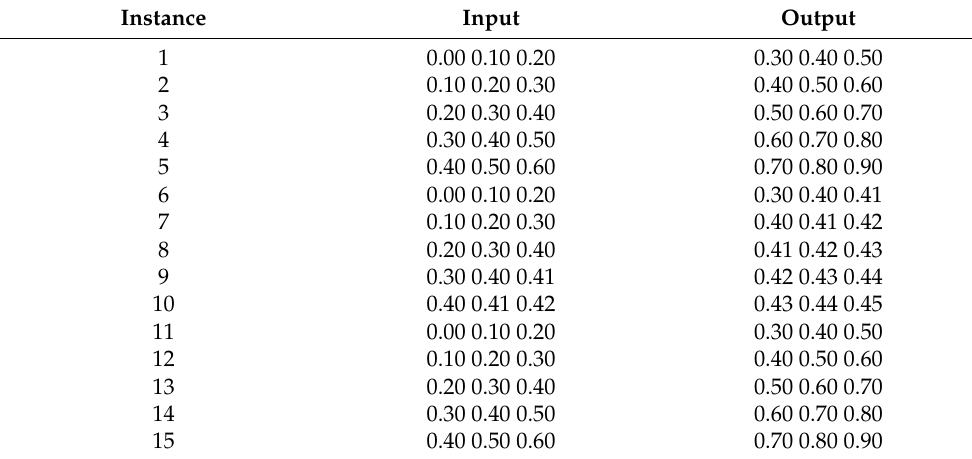
Table 2. The dataset for a simple asymmetric bimodal trajectory problem.